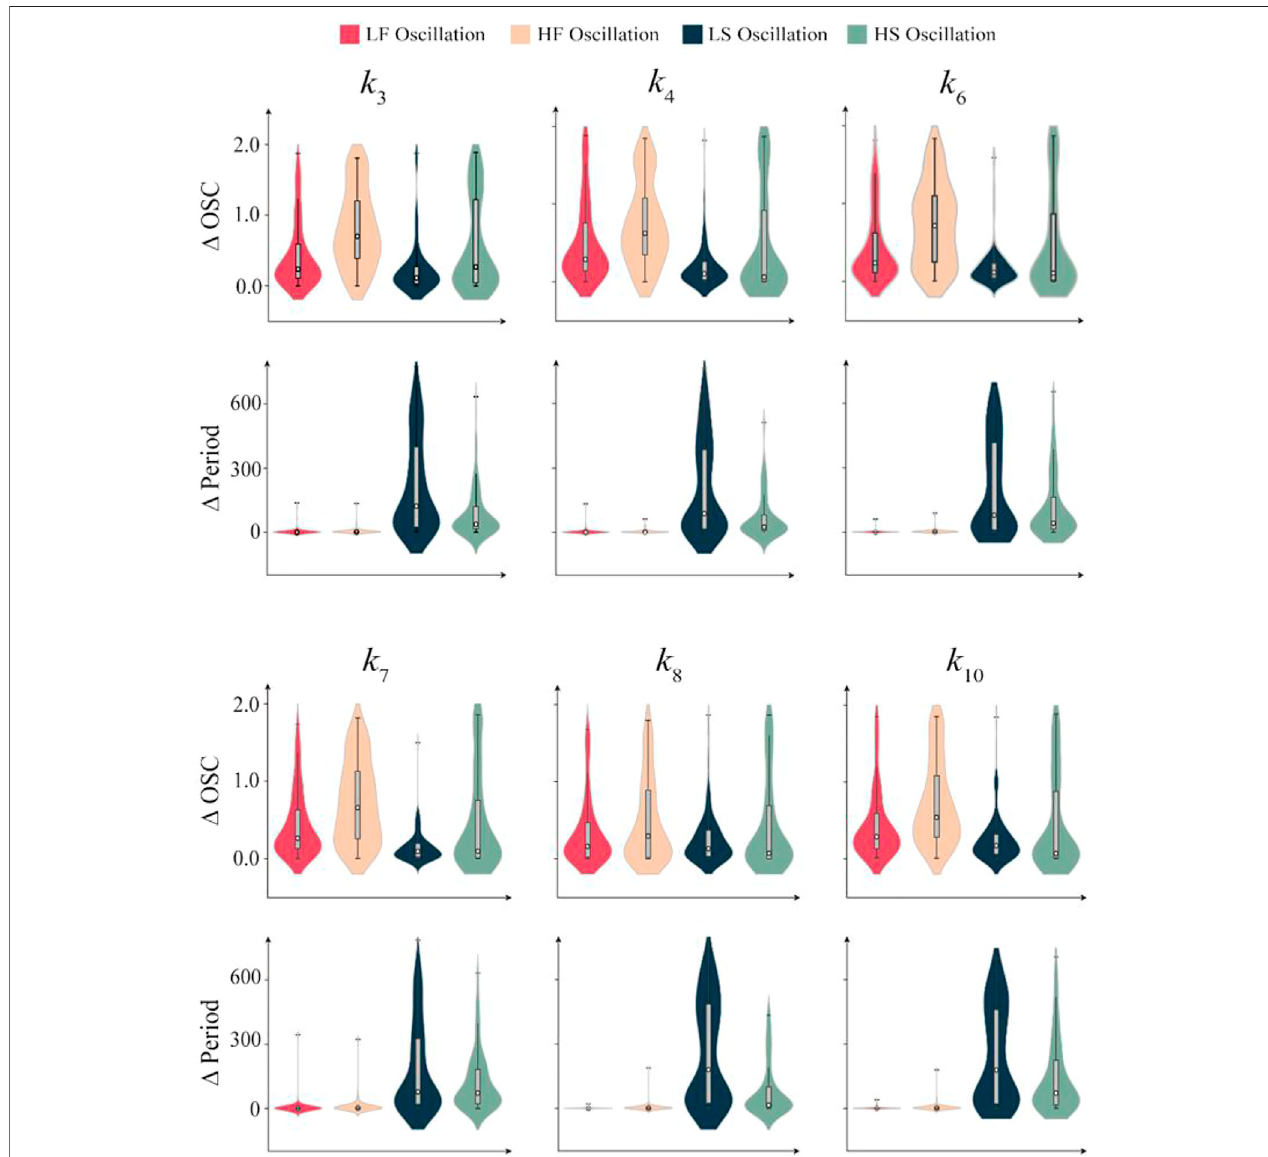
FIGURE 8 | Parameter sensitivity analysis of the four types oscillation behaviors. The Magenta violin plots represent LF oscillation, the sallow violin plots represent HF oscillation, the navy violin plots represent LS oscillation and the turquoise violin plots represent HS oscillation. The box diagrams embedded in violin diagrams show the extreme and median values of the variations of OSC and period. 100 random systems corresponding to each biological oscillation behavior were considered. The box plots are embedded in each violin, and white dots represent the median of statistical data.